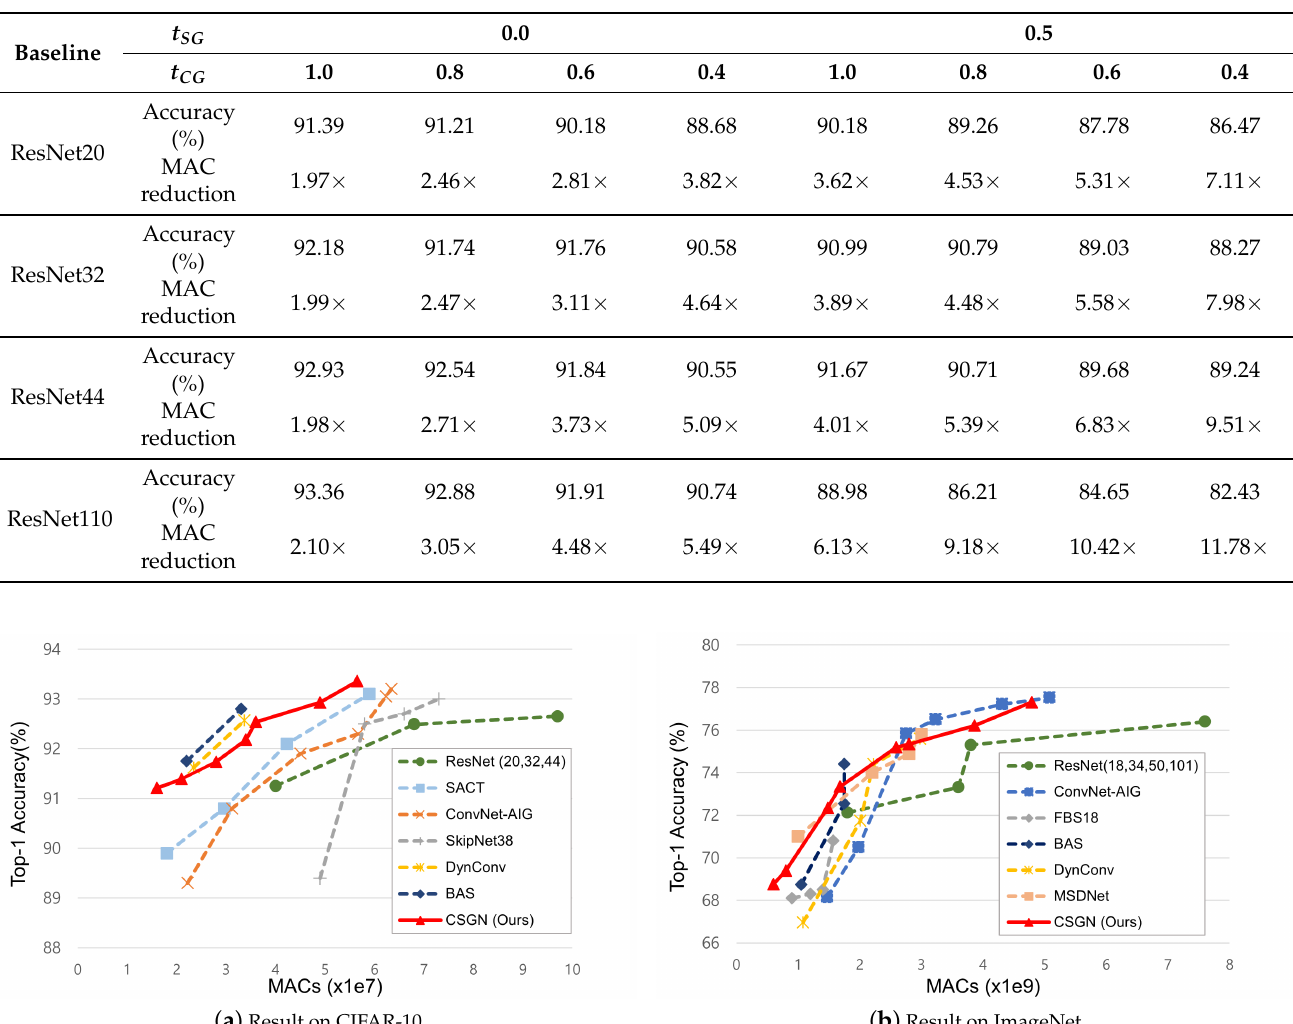
Table 3. Top-1 accuracy and the MAC reduction of the CSGN on CIFAR-10.